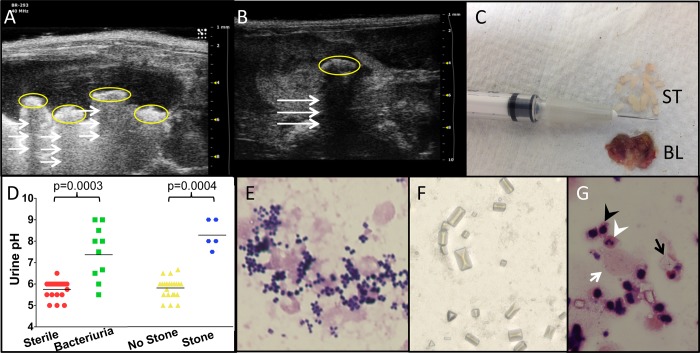

Mgb-/- female mice exhibit struvite urolithiasis associated with spontaneous UTI.Ultrasound of Mgb-/- female mice demonstrates bladder (A) and kidney (B) echogenic foci representing stones (circled) with acoustic shadowing (arrows). (C) Bladder stones (ST) harvested from a Mgb-/- female bladder (BL) with a spontaneous UTI. Stone analysis confirmed struvite (magnesium ammonium phosphate) as the major chemical component. (D) Urine from Mgb-/- females with bladder stones or UTI is alkaline compared to Mgb-/- females with sterile urine or lacking stones. p values by Mann-Whitney U test are indicated above the graph. (E) Gram stain of urine sediment from Mgb-/- females with struvite bladder stones demonstrates Gram-positive cocci in clusters consistent with Staphylococcal species. 100x objective. (F) Bright field light micrograph of urine sediment from Mgb-/- females with struvite bladder stones demonstrates typical “coffin-lid” appearance of struvite crystals. (G) Wright-Giemsa stain showing struvite crystals (black arrow), mononuclear and polymorphonuclear leukocytes (black and white arrowheads, respectively), and desquamated urothelial cells (white arrow) in urine sediment from an Mgb-/- female with spontaneous bacteriuria. 100x objective.